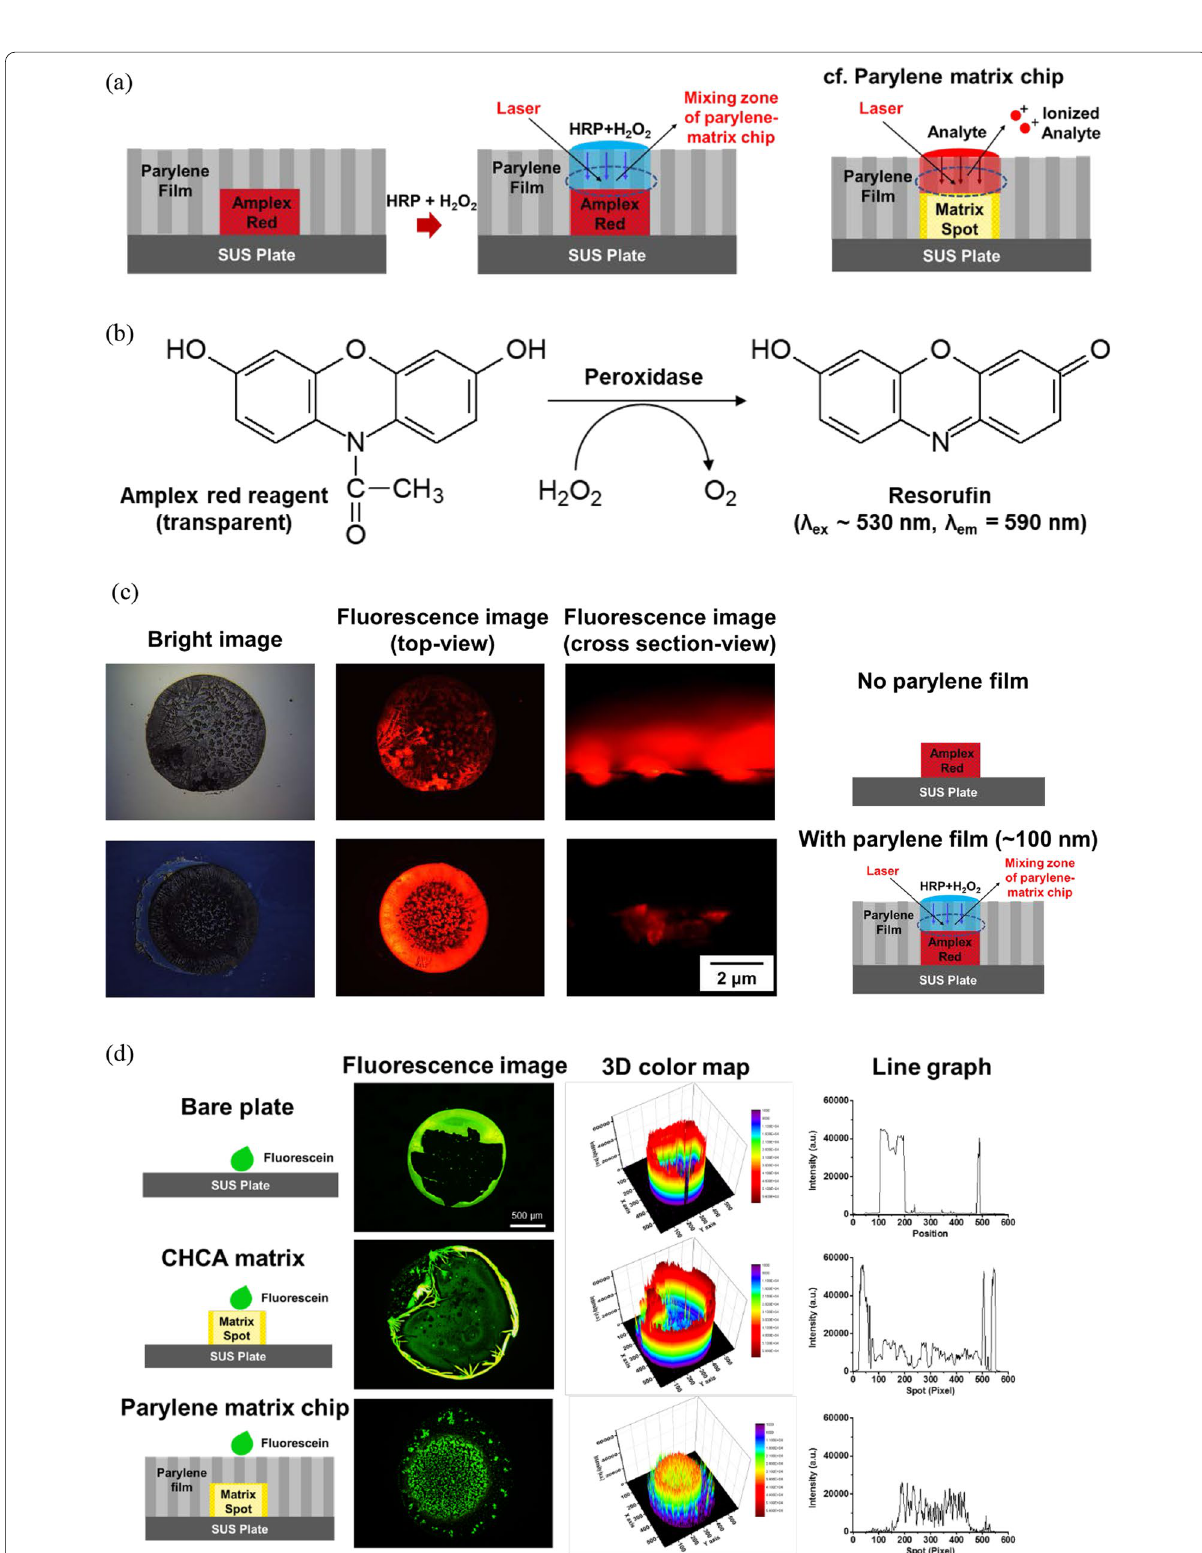
Fig. 2 Characterization of the parylene matrix chip. a Scheme of the mixing zone of parylene‑N film. b Amplex Red assay reaction with H 2 O 2 and peroxidase. c Fluorescence image of Amplex Red assay with or without the parylene‑N film. d Fluorescence images of bare plate, CHCA matrix, and parylene matrix